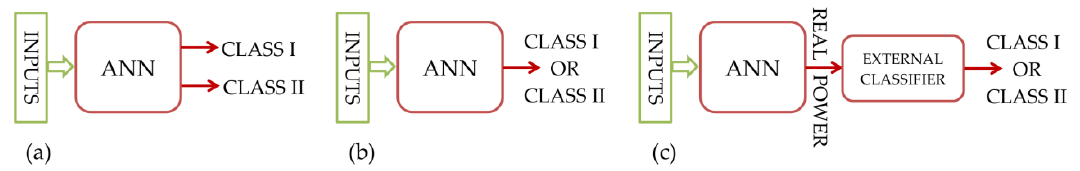
Figure 5. The structure of artificial neural network (ANN)-based models used in dichotomous classification problems.